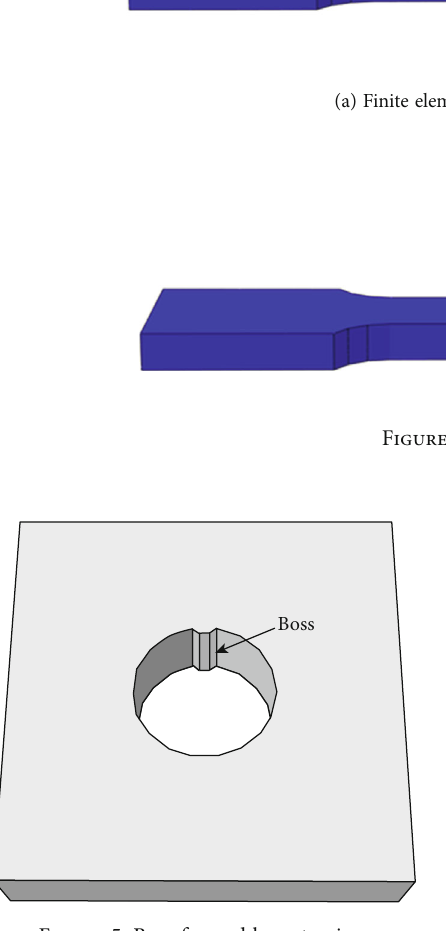
Figure 5: Boss formed by